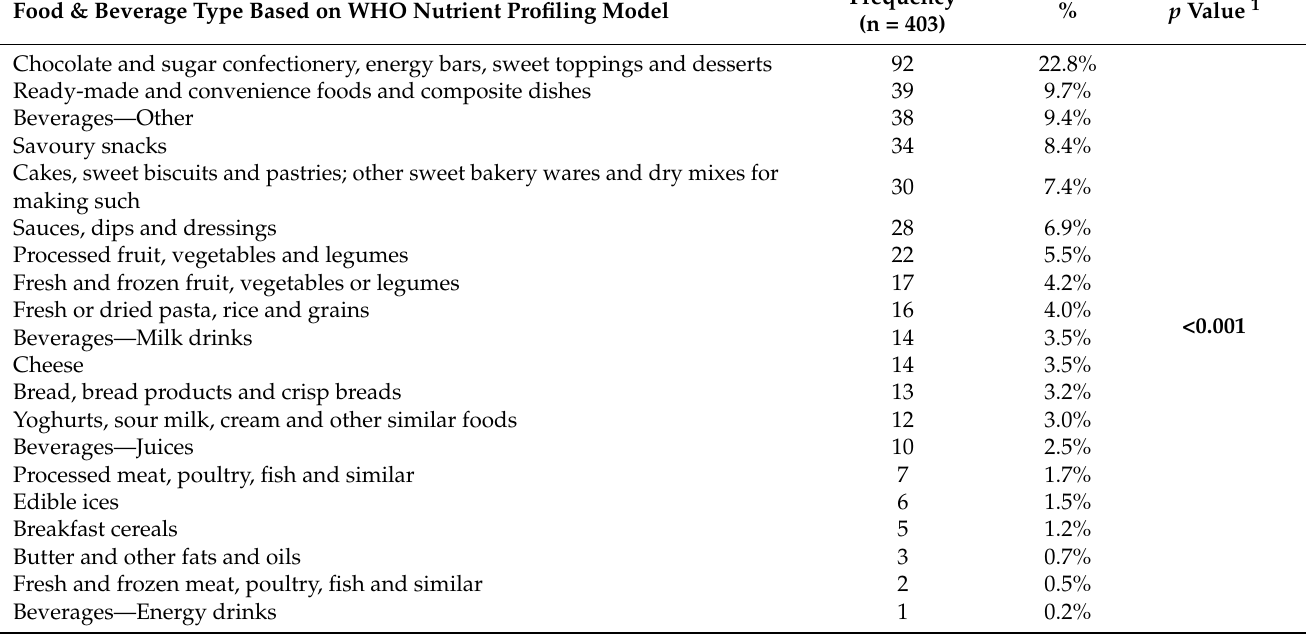
Table 1. Food and beverage types based on the WHO Nutrient Profiling Model ordered by frequency of appearance in influencer videos (n = 264) or posts (n =